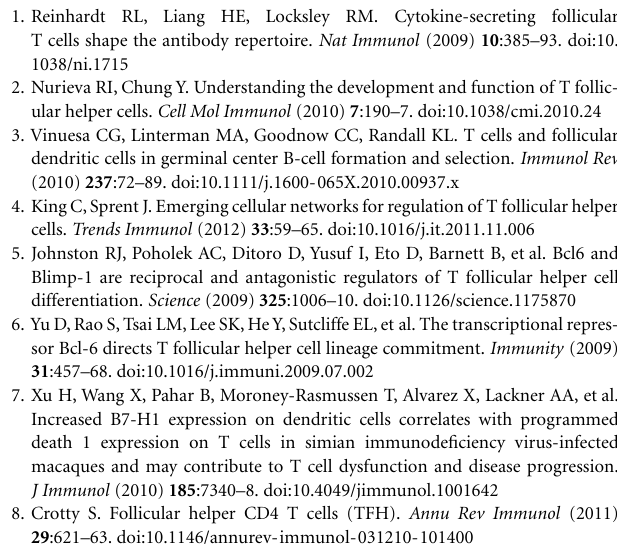
FIGURE 4 | Correlation of PD-1 HIGH CD4T cells with B cell subsets in juvenile/adult macaques, and effects of PD-1 blockade on antibody production in autologous LN-derived PD-1 HIGH CD4T/B cells co-cultures . (A) Dot plot showing gating strategy for defining B cell subsets in lymph nodes. Naïve (IgD + CD27 − ), memory (IgD + CD27 + ), switched memory (IgD − CD27 + ), and mature (IgD − IgG + ) B cell subsets are distinguishable; (B–E) correlation of PD-1 HIGH CD4T cells with B cell subsets in juvenile/adult macaques. Note that PD-1 HIGH CD4T cells